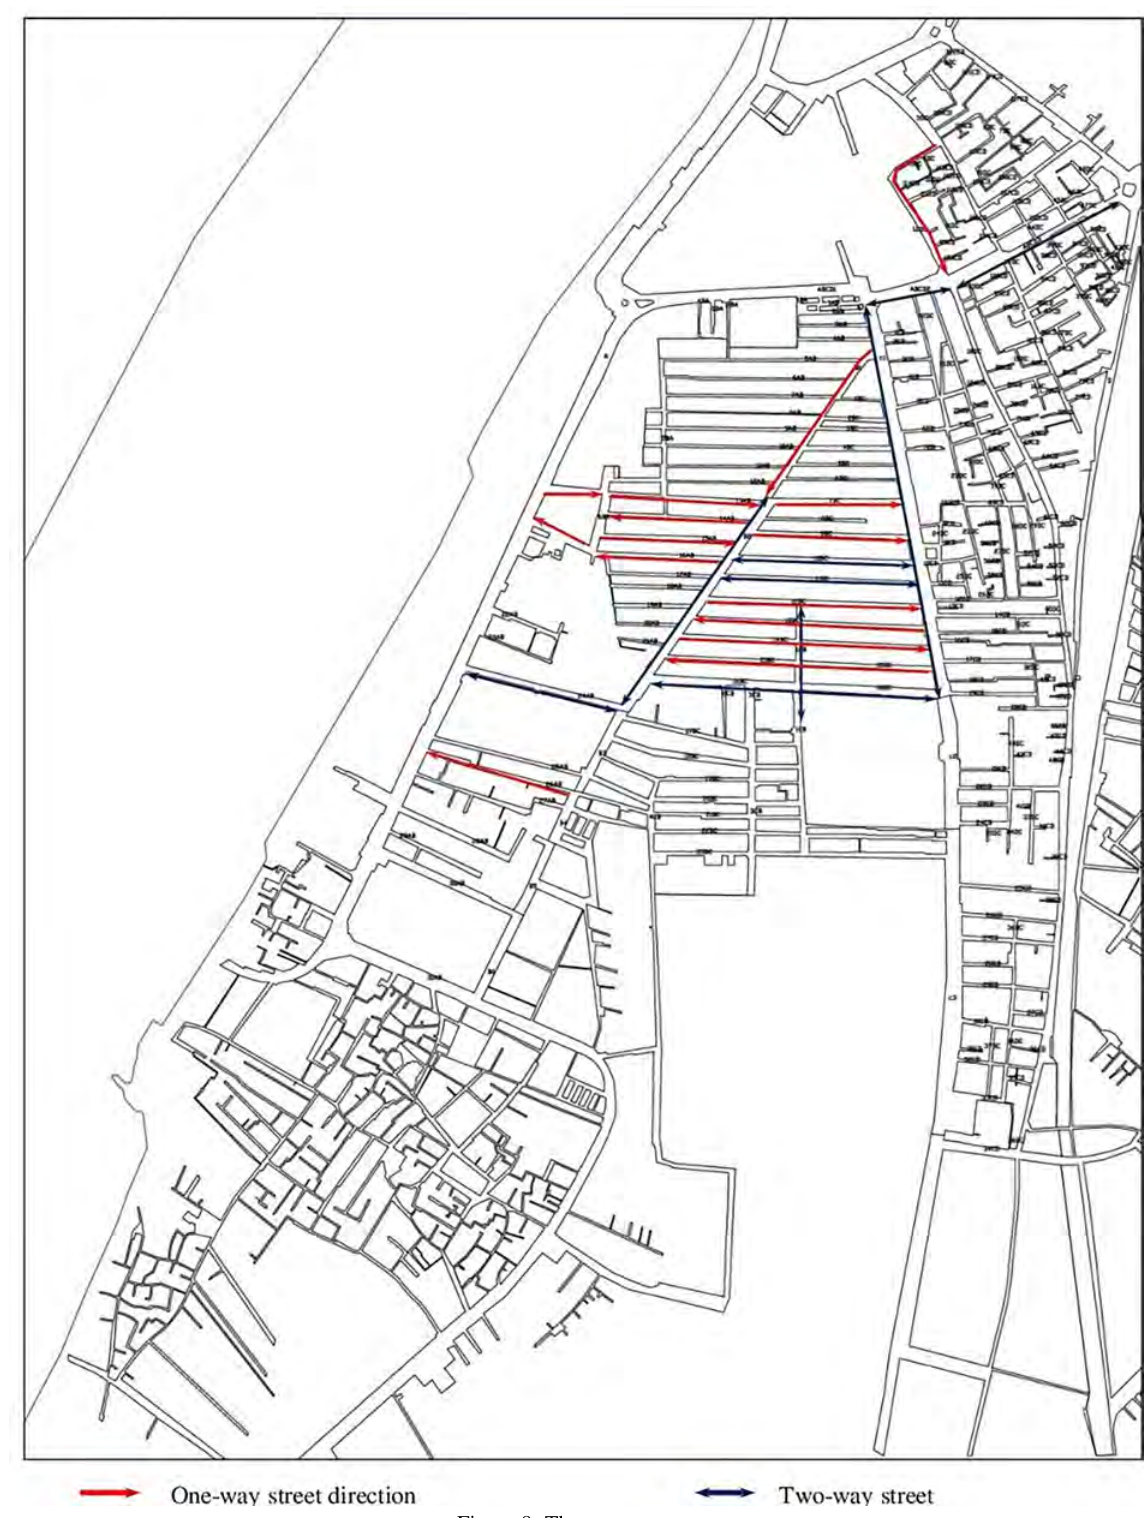
Figure 8. The current state